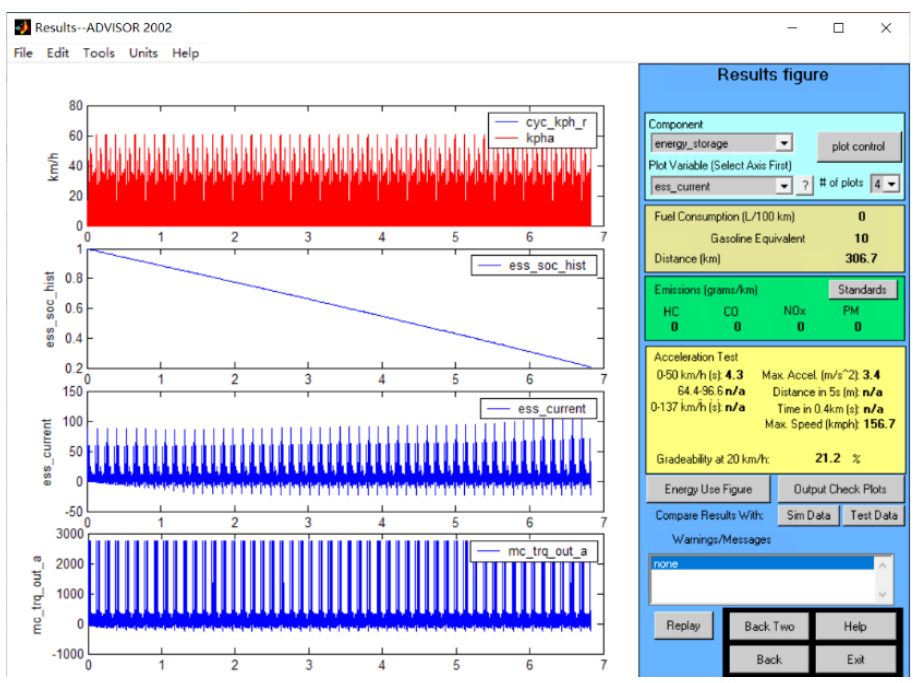
Figure 14. Simulation results of experiment 6.